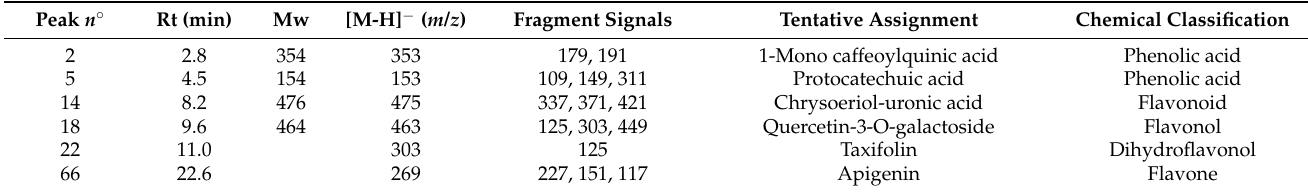
Table 3. Major phytochemical compounds identified in the bark extract (BE).